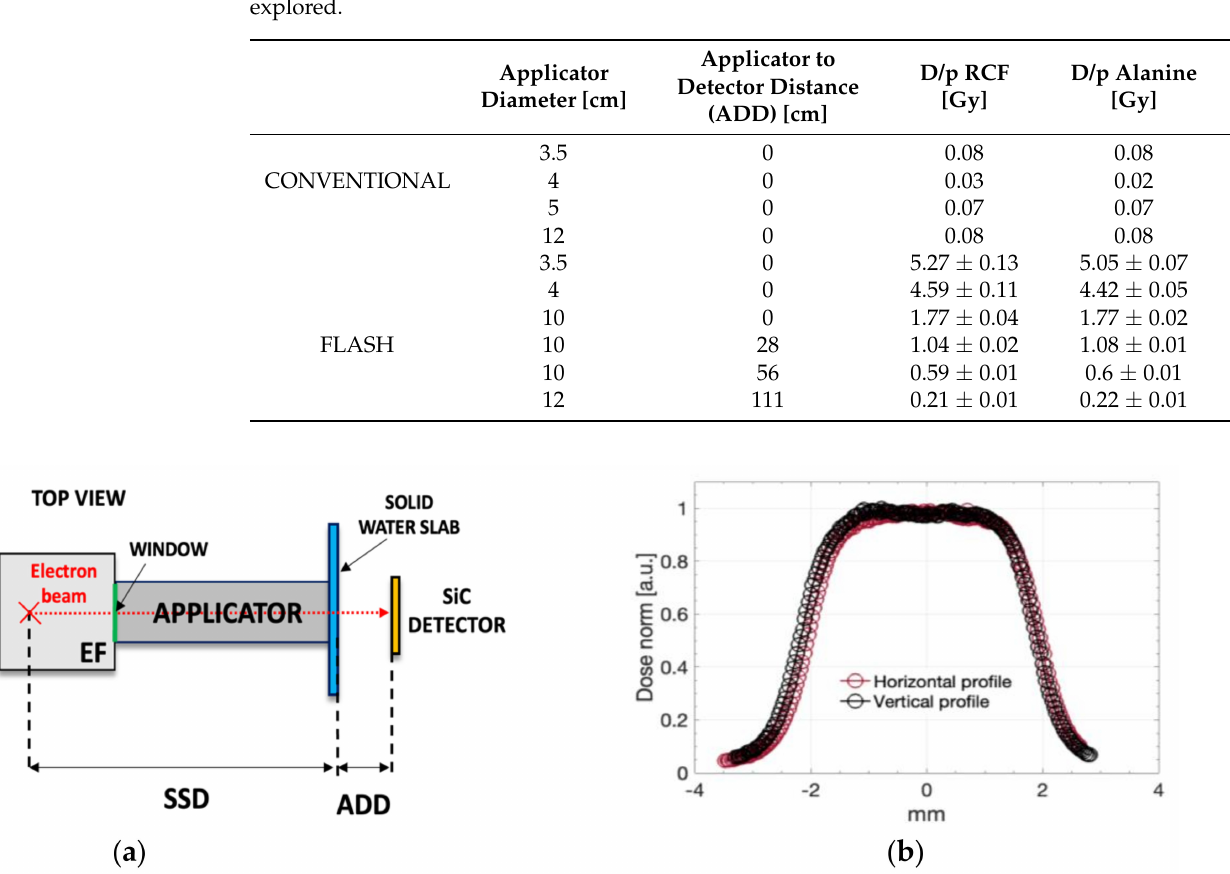
Table 2. Irradiation conditions and correspondent dose per pulse for different applicators and distances from them for 9 MeV electron beams. As evident from the fist column, only for the 10 cm collimator different distances of the detectors from the final part of the applicator (ADD) were explored.